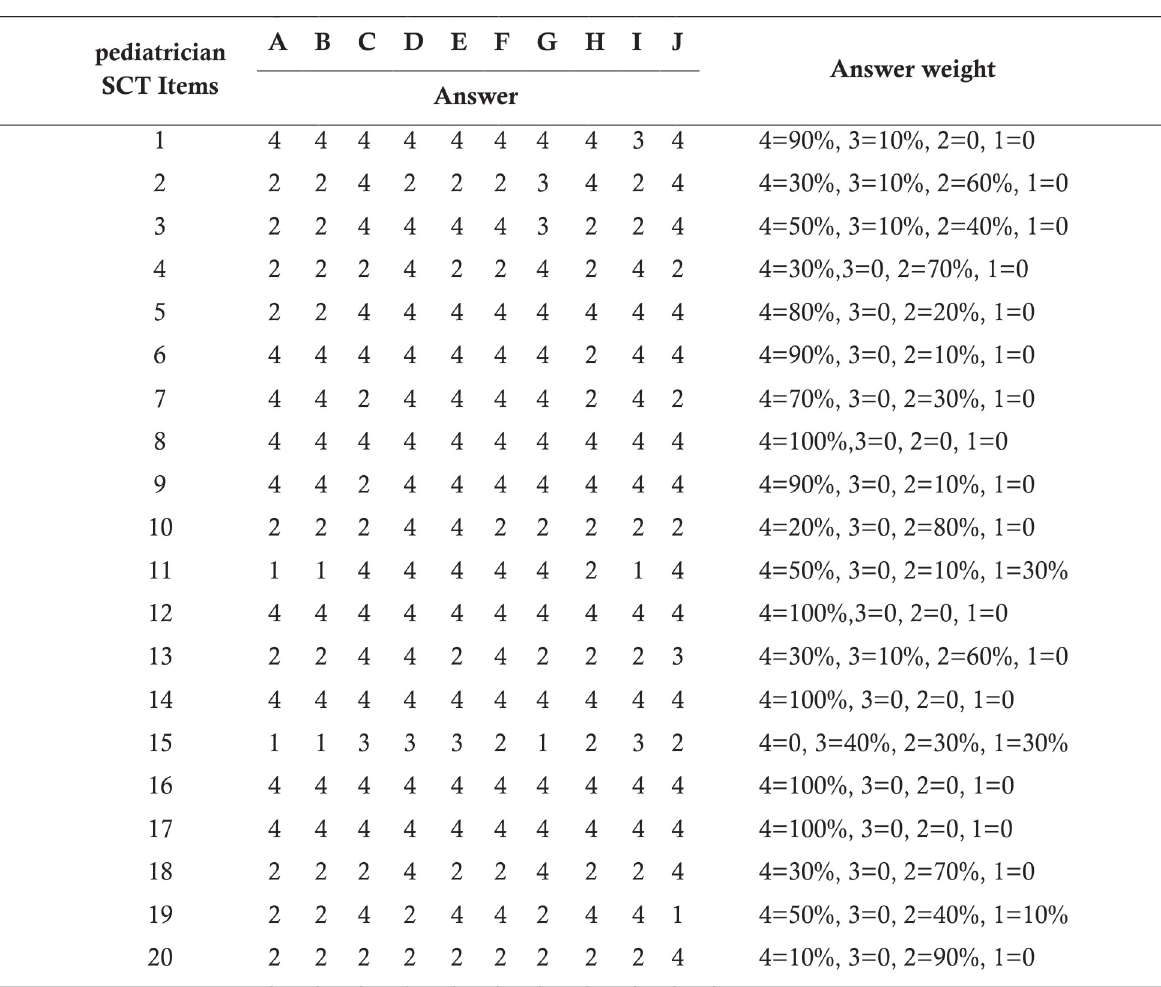
The Difference of Clinical Reasoning Competence between Pre-Clinical Students and Clinical ... SCT concordance result by 0